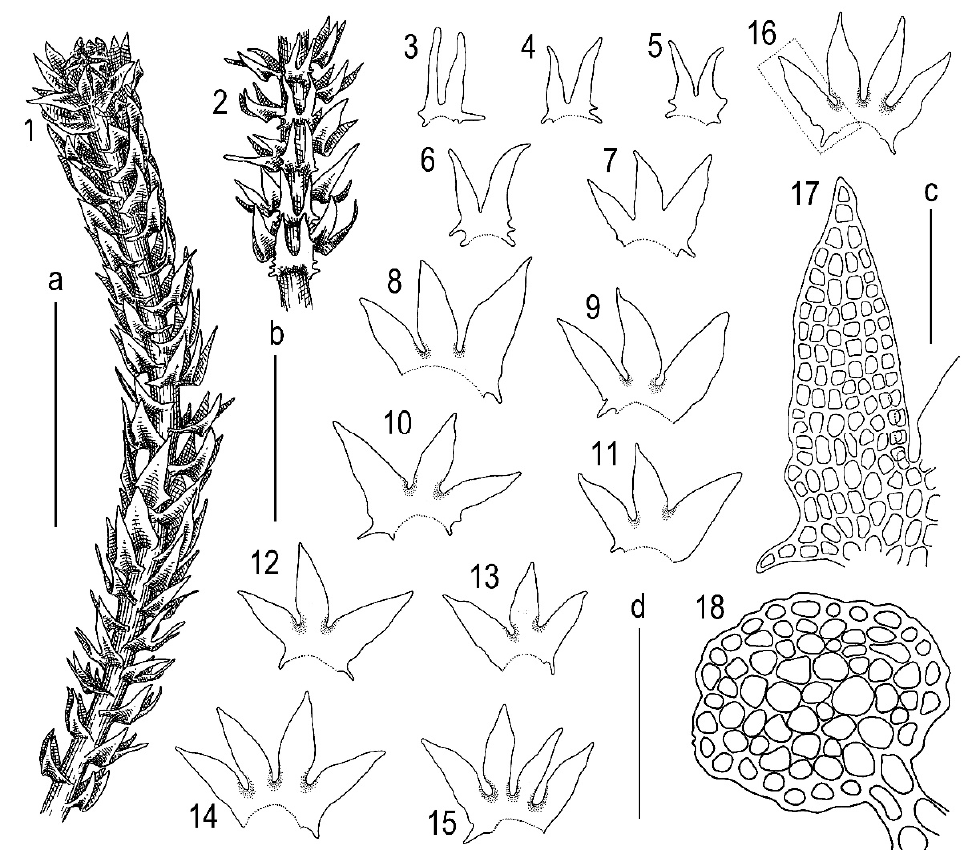
Figure 3. Tetralophozia sibirica Vilnet et Bakalin: 1 —plant habit. dorsal view. 2 —plant habit. ventral view. fragment; 3 – 6 —underleaves; 7 – 16 —leaves; 17 —leaf lobe showing cells (from 16); 18 —stem cross section; Scales: a —1 mm. for 1,2; b —500 µm. for 4–13,16; c —100 µm. for 17,18; d —500 µm. for 3,14,15. All from holotype.